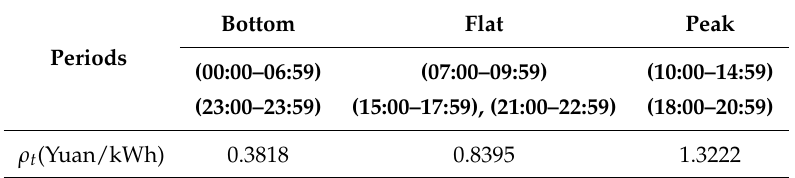
Table 3. Time-of-use (TOU) Price of charging in China’s electricity market.